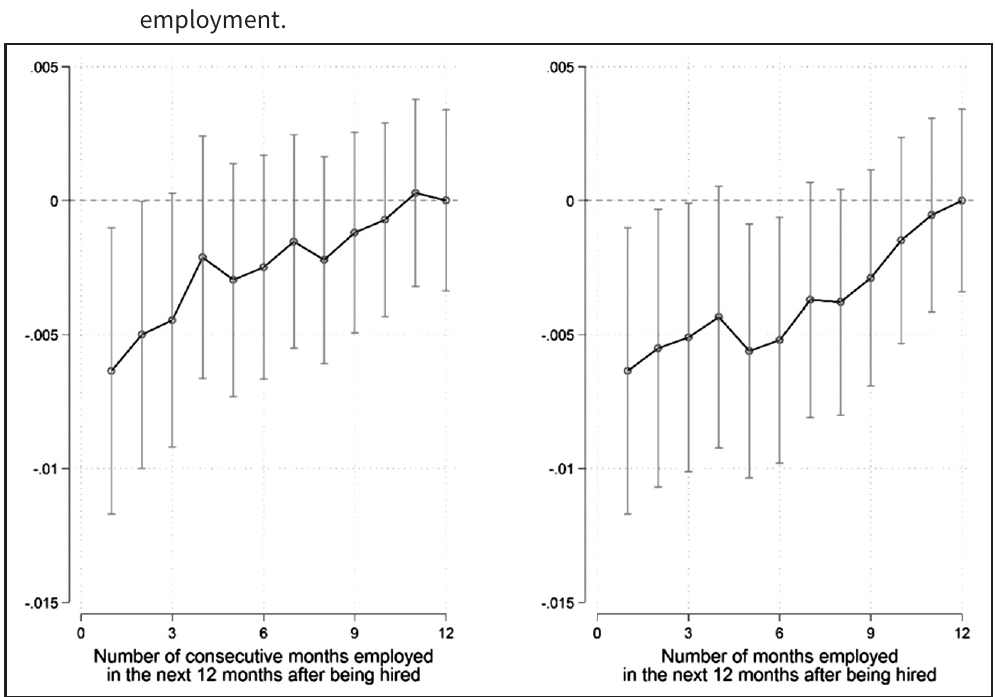
Figure A3 The effect of the abolition of the subsidy on the probability of finding employ- ment lasting 1–12 (consecutive) months using the more stringent definition of employment.